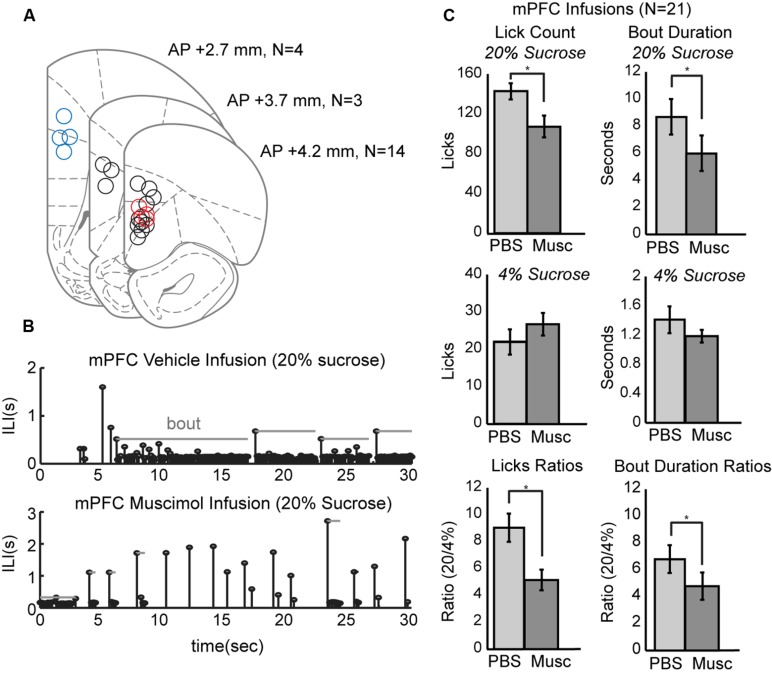
Effects of reversibly inactivating the mPFC in the operant licking task. (A) Coronal depiction of infusion sites for muscimol within the mPFC. Sites at 3.7 mm A/P were considered to be in the rostral mPFC area. Nine of these sites were clearly within the prelimbic area. Sites at 2.7 mm were considered to be in the caudal mPFC area. Dual cannula located in both rostral (red) and caudal (blue) mPFC are included as well. (B) Temporal patterns of licking were dramatically altered by inactivation of mPFC. Top: Licking for 20% sucrose following infusion of PBS vehicle occurred in sustained bouts. Bottom: Licking following inactivation of mPFC with muscimol (Musc) was associated with reduced bout durations and reduced overall licking. (C) Inactivation of mPFC decreased licking and the duration of licking bouts for the higher, but not the lower, value fluid and reduced the ratios of licking for the higher-to-lower value fluids (a measure of incentive contrast).